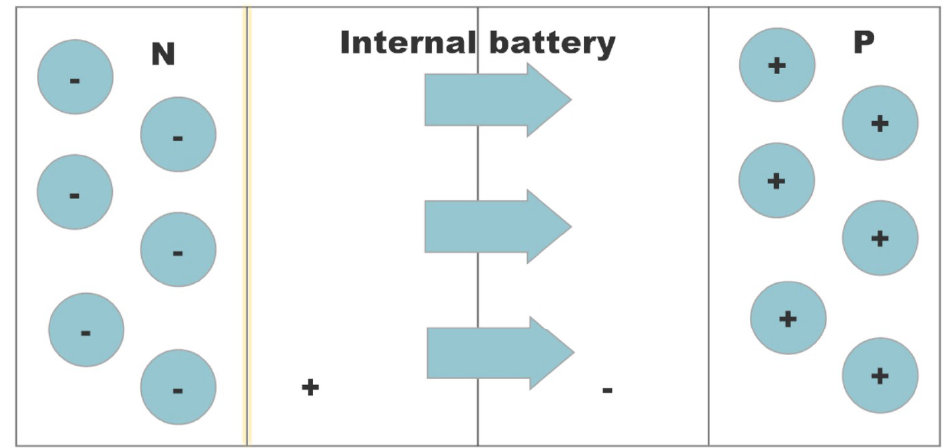
Figure 1. The principle diagram of the photovoltaic